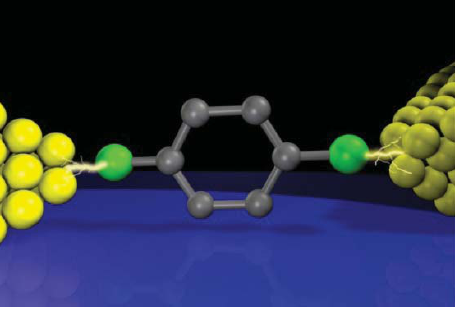
Figure 1. Schematic model of a single-molecule